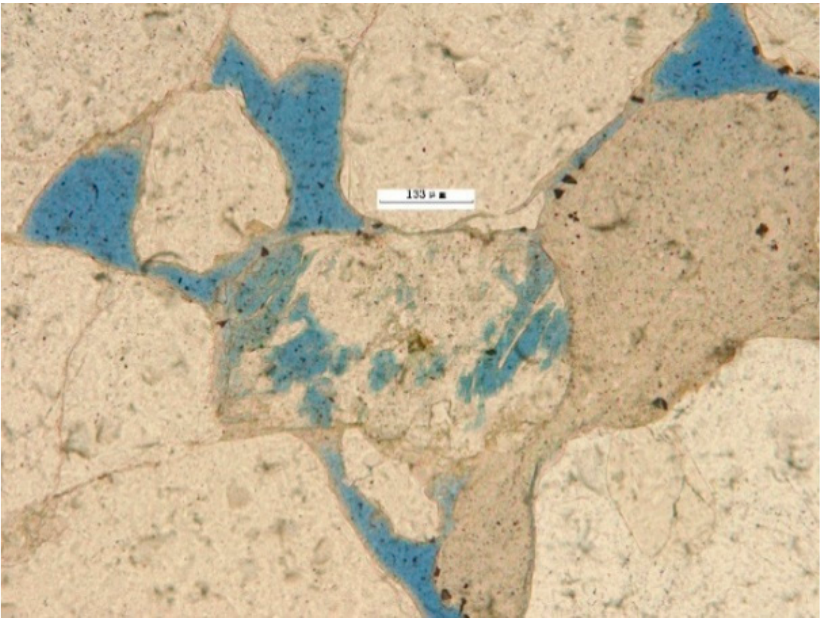
Figure 9. Pore fluid dissolution of feldspar through chlorite lining.